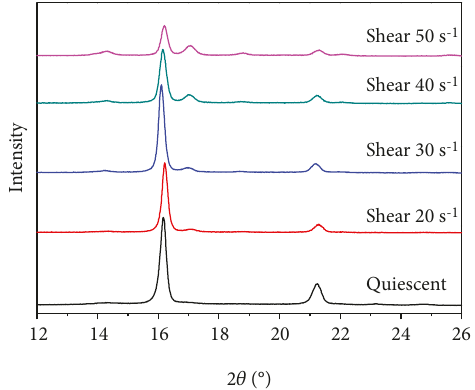
Figure 7: WAXD patterns of β -nucleated iPP sheared at 170 ° C for 10s under di ff erent shear rates.